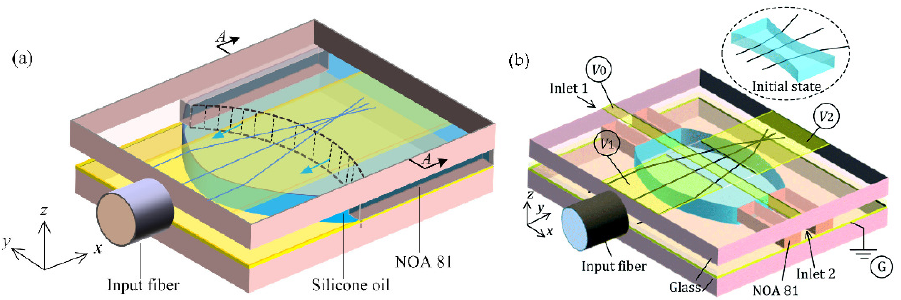
Figure 25. Schematic design of the DEP lens, the DEP force drives the liquid–air interface from concave to convex through: ( a ) one side [129] and ( b ) both sides [130]. Reprinted with permission from Refs. [129,130]. 2018 The Optical Society and 2018 Royal Society of Chemistry.